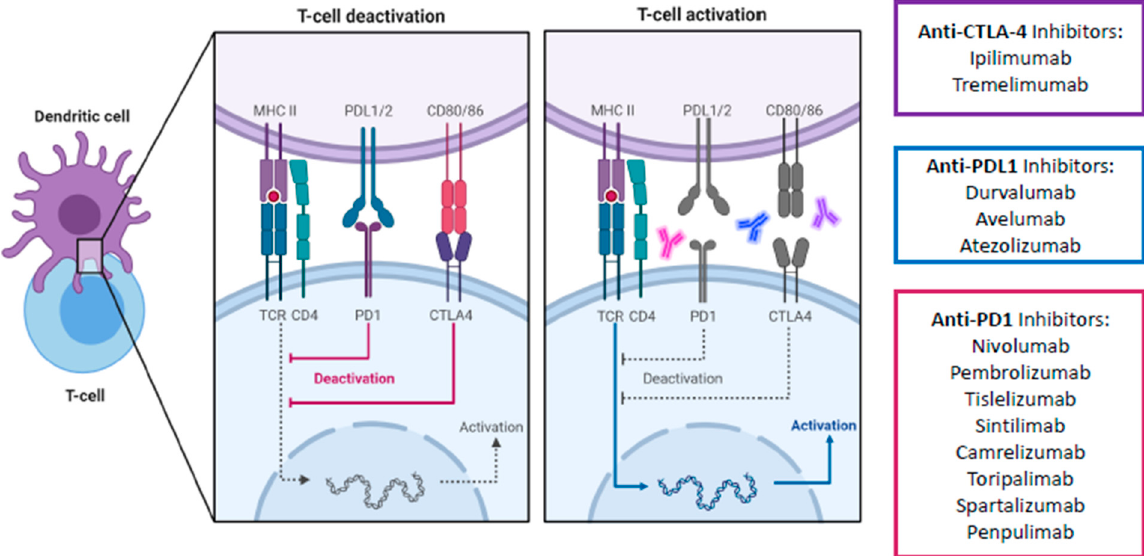
Figure 3. Schematic overview of main immune checkpoint inhibitors including their mechanism of action for advanced HCC treatment. The signaling cascade of the PD-1/PD-L1 and CTLA4 pathway and the corresponding therapeutical immune-checkpoint inhibitors. Due to the higher affinity of CTLA-4 to CD80/86 than the co-stimulatory CD28, CTLA-4 successfully binds to CD80/86 and antagonizes the stimulatory signal by the interaction of CD28 with CD80/86. As a result, CTLA-4 causes an inhibition of T cell activation. Similarly, the interaction of PD-L1 with its receptor PD-1 also disrupts the activation of T cells, therefore influencing immune activity in a negative way. CTLA-4, cytotoxic T-lymphocyte-associated protein 4; PD1, programmed death-1 protein; PDL1, programmed death- ligand 1; MHC II, major histocompatibility complex II; TCR, toll-cell receptor; CD4, cluster of differentiation 4. Created with biorender.com.